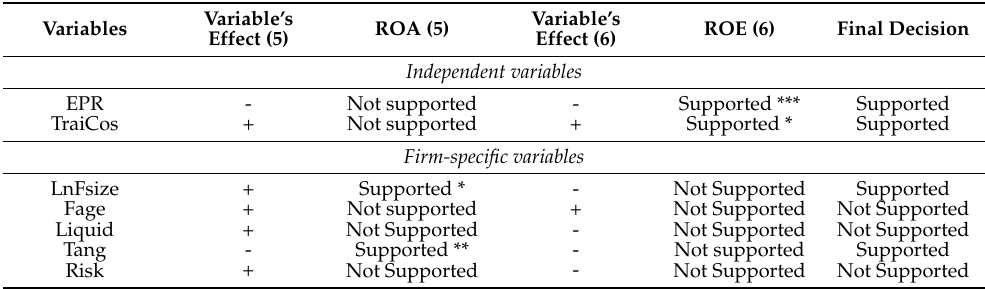
Table 10. Summary of hypothesis verification of model (5) and (6).